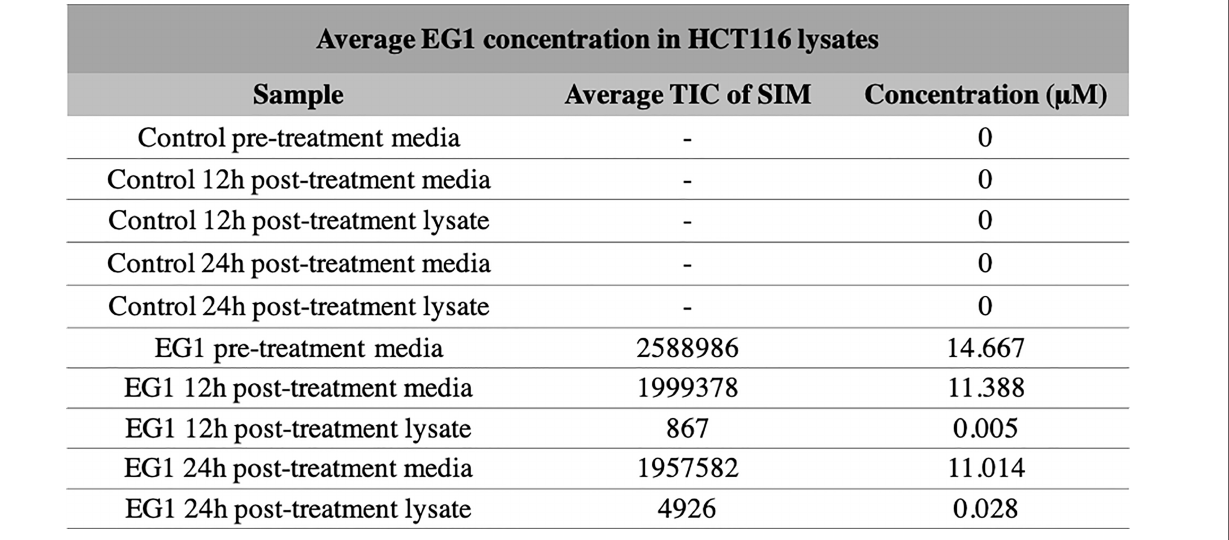
FIGURE 3 | Selective ion monitoring mass spectrometry of EG1 in media and cell lysates post-treatment. The concentration of EG1 in the treatment medias and cell lysates of HCT116 cells were measured using selective ion monitoring mass spectrometry to determine EG1 ’ s stability in media and it ’ s uptake into cells. EG1 was measured in both the control and EG1 drug conditioned pre-treatment medias as well as in post-treatment medias recovered from cell cultures after 12 hour and 24-hour incubations. There was no detection of EG1 in the control medias throughout the incubational periods. In the drug conditioned pre-treatment medias the average concentration of EG1 was ~10 m M lower than the expected 25 m M (n=2). Additionally the post-treatment medias at both 12 hours and 24 hours had reduced by 3 m M from the pre-treatment concentration yet we observed EG1 uptake of only 0.005 m M and 0.028 m M respectively into the HCT116 cells